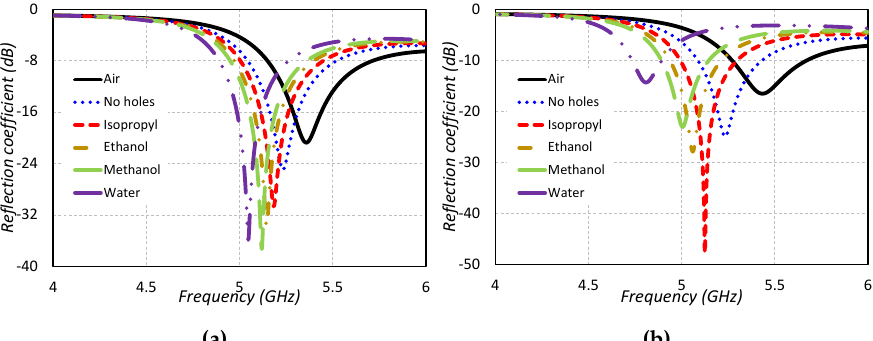
Figure 6. Reflection coefficient of the sensors for different liquid chemicals ( a ) Type 1 sensor ( b ) Type 2